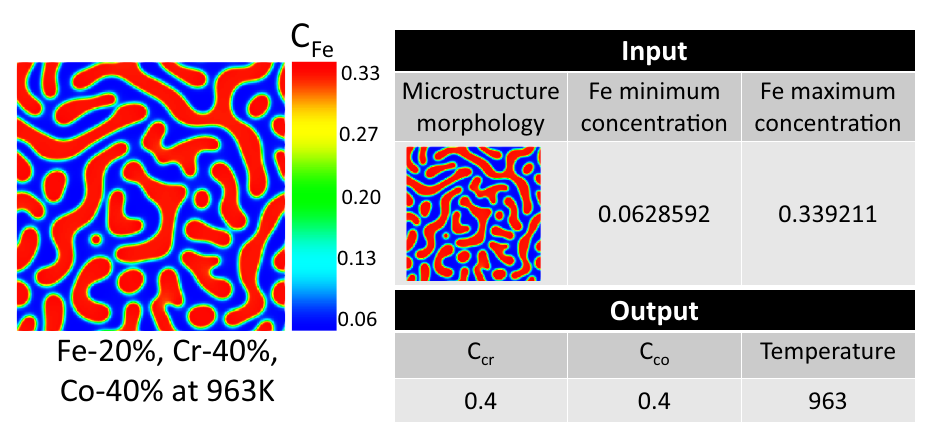
Figure 4. A sample workflow of dataset